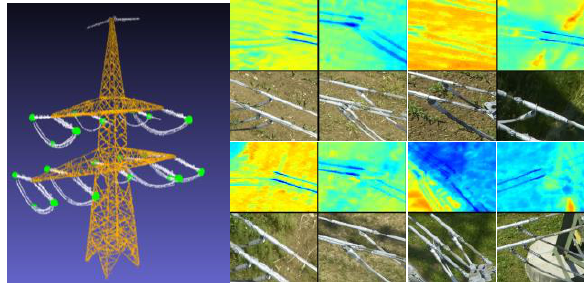
Figure 8. Sample of thermal inspection of